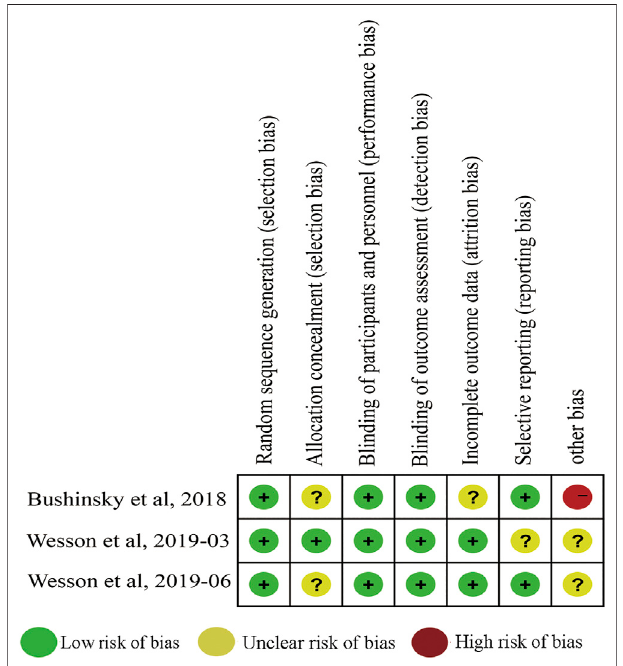
FIGURE 2 | Bias risk assessment for inclusion in the study.